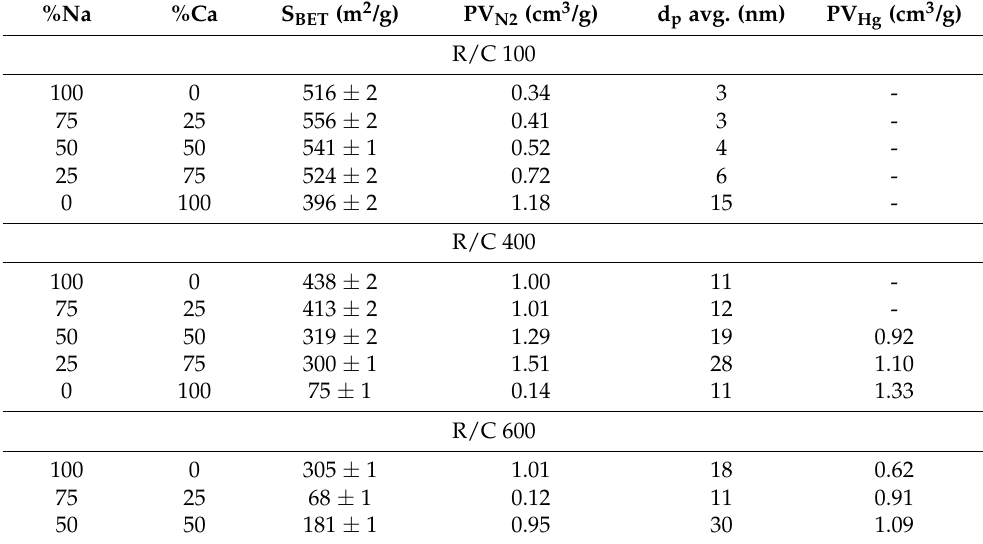
Figure 2. The sorption isotherms obtained for the resorcinol–formaldehyde xerogels produced using 20% solids content and ( a ) R/C 100, ( b ) R/C 400, and ( c ) R/C 600. Table 2. The textural properties obtained for resorcinol–formaldehyde xerogels produced using 20% solids content.